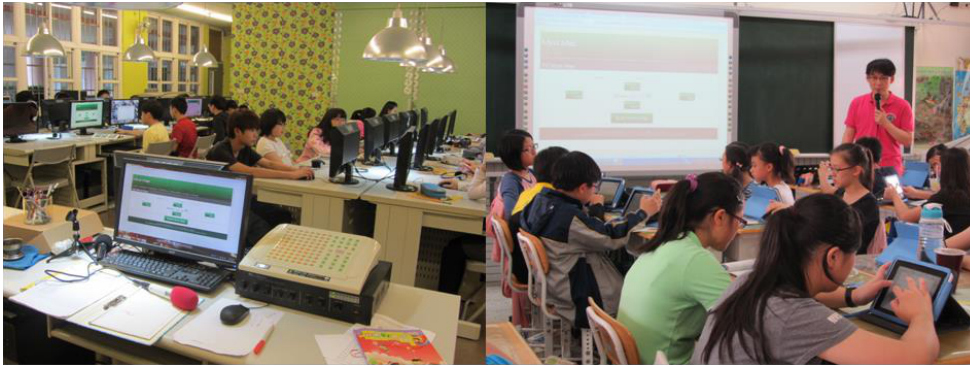
Figure 8. The learning activities of the control group.